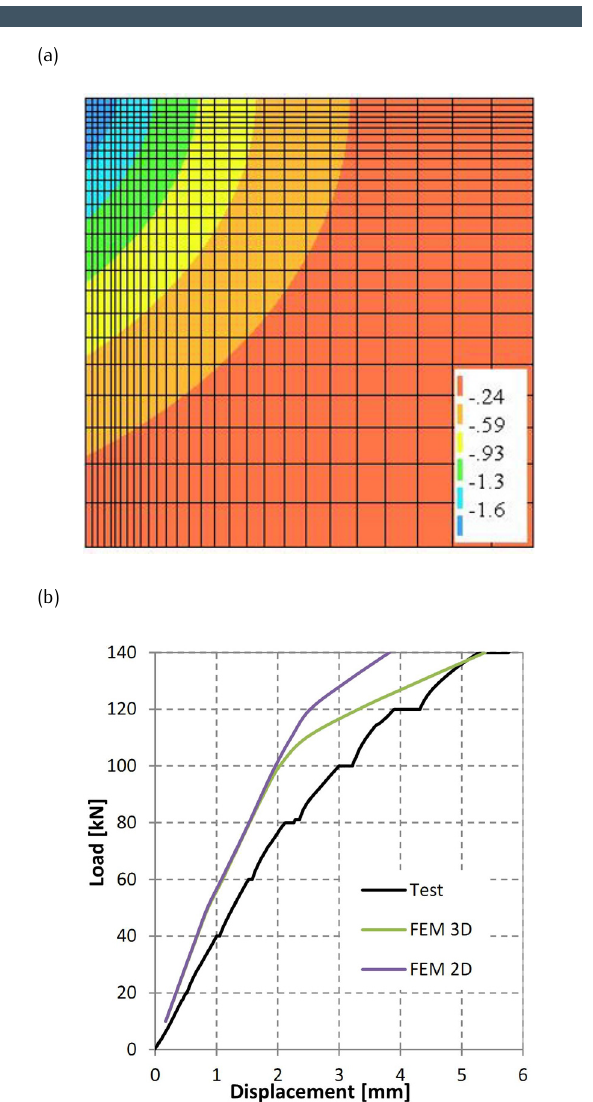
Figure 18. Crack pattern at top surface for edge load, (a) Load 100 kN, (b) Load 140